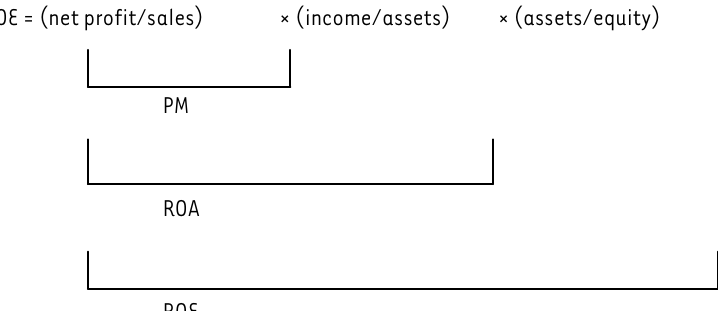
FIGURE 2: Du Pont Analysis Source: Correia, et al.,